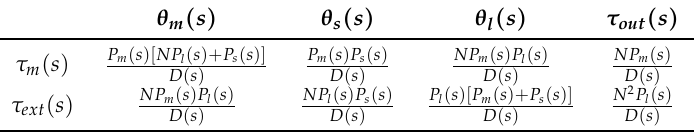
Table 2. Transfer functions of RFSEA.